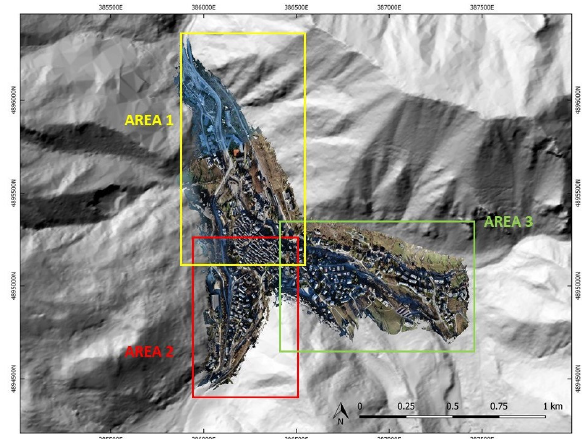
Figure 7. Processing Strategy 1. The 3 areas highlighted yellow, red and green represent the different processing blocks in which images acquired in the field were grouped .